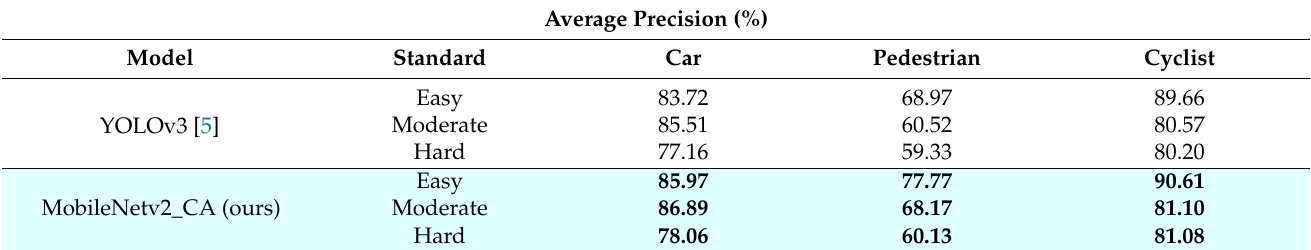
Table 5. Performance comparison using KITTI validation set (where Easy, Moderate and Hard refer to the precision under easy, moderate and hard standards,